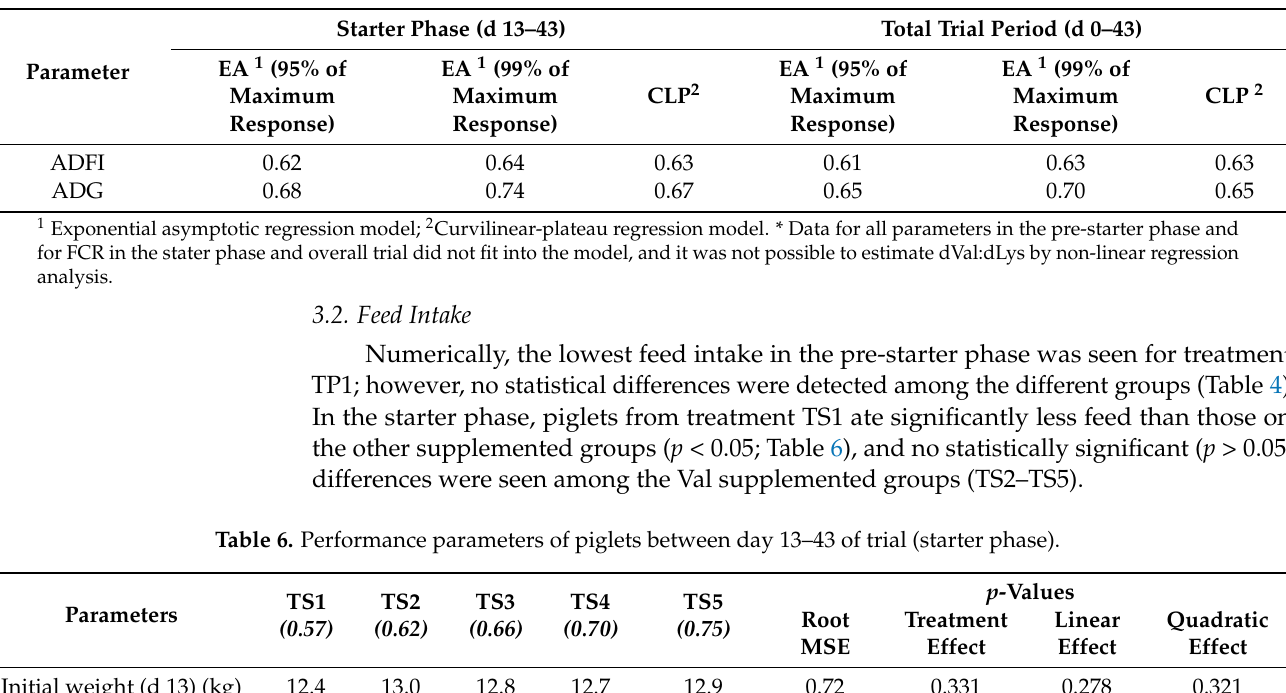
Table 5. Estimated optimal dVal:dLys ratios for performance in pigs in different phases by exponential asymptotic and curvilinear-plateau regression model *.